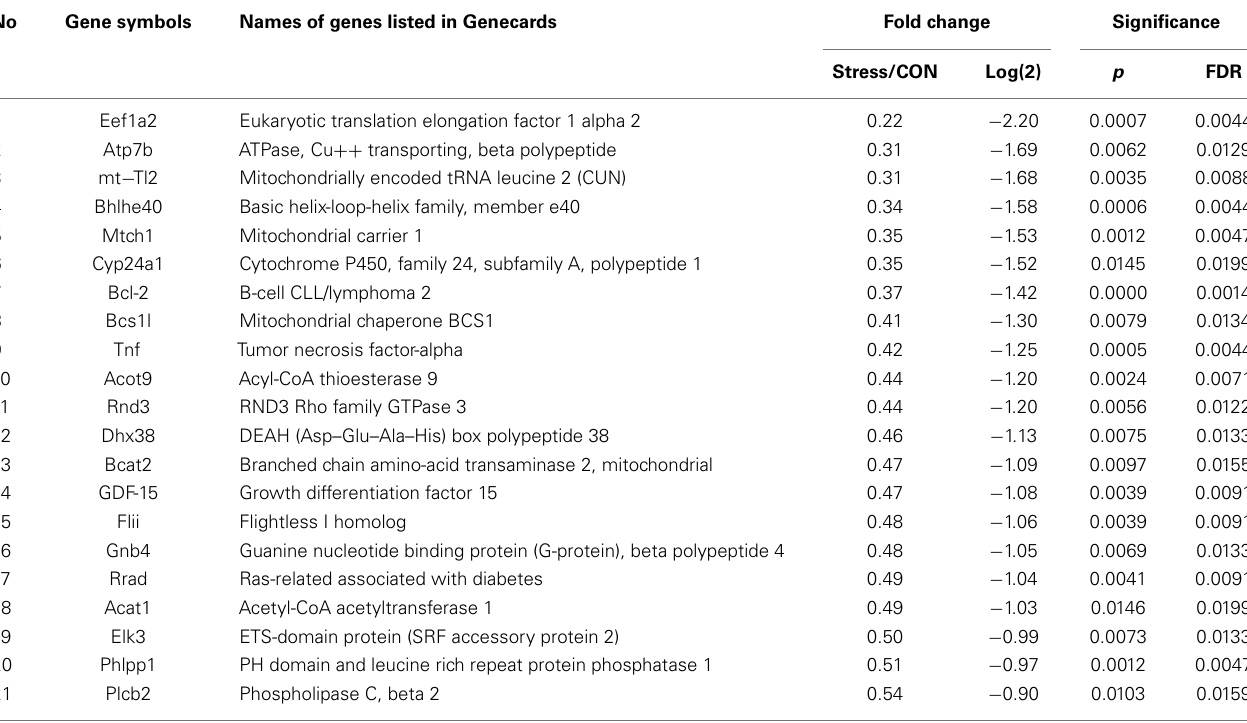
Table 1 | Downregulated genes in amygdala (14days after stress)